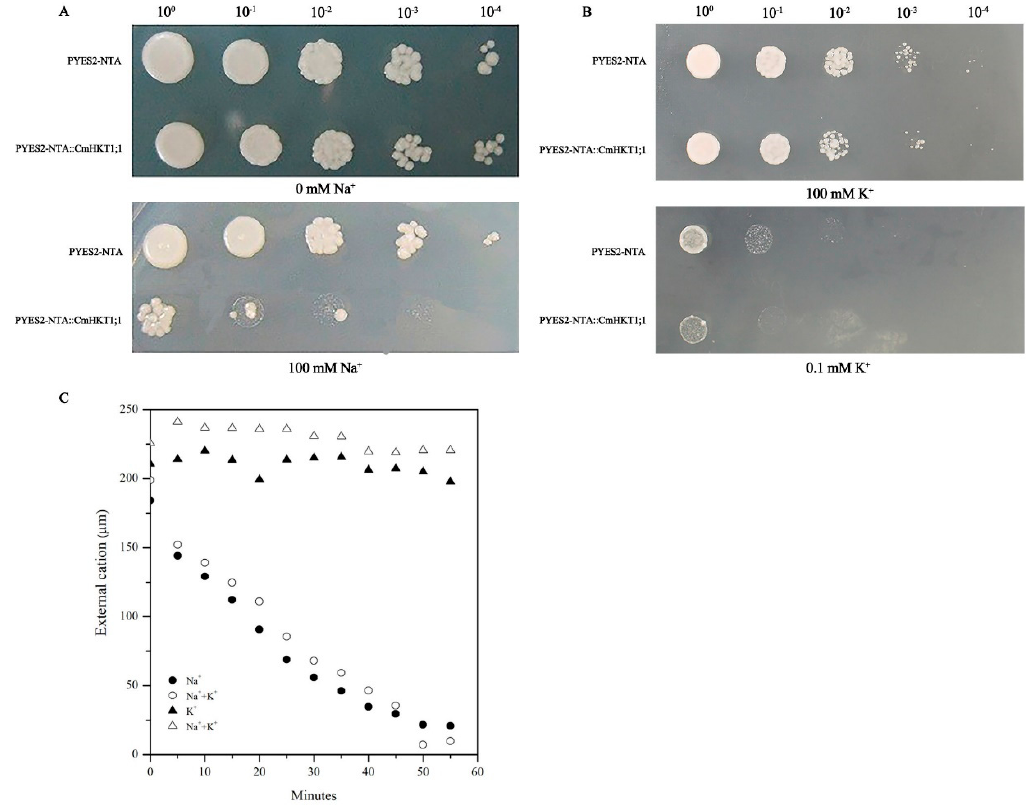
Figure 5. Functional characterization of CmHKT1;1 expressed in S. cerevisiae . ( A ) Growth inhibition tests of S. cerevisiae G19 ( Mat a, his3, leu2, ura3, trp1, ade2, and ena1::HIS3::ena4 ) expressed the CmHKT1;1 gene and empty vector. ( B ) K + uptake complementation test in W ∆ 6. Growth of yeast strain W ∆ 6 ( Mat a ade2 ura3 trp1 trk1D::LEU2 trk2D::HIS3 ) cells harboring the CmHKT1;1 and empty vector. All transformants were grown on AP medium containing the indicated concentration of KCl and NaCl. ( C ) Time course of Na + and K + depletion in W ∆ 6 yeast cells expressing CmHKT1;1 . K + -starved cells were suspended in testing buffer (10 mM MES-Ca 2+ , pH 6.0) supplemented by 2% galactose, and samples were taken at intervals after the addition of NaCl (200 mM) or KCl (200 mM). Depletion of K + and Na + was determined by atomic absorption spectrophotometry. Changes in Na + concentration (circles) in the absence (closed circles) or presence of K + (open circles), and changes in K + concentration in the absence (closed triangles) or presence of Na + (open triangles) were recorded.